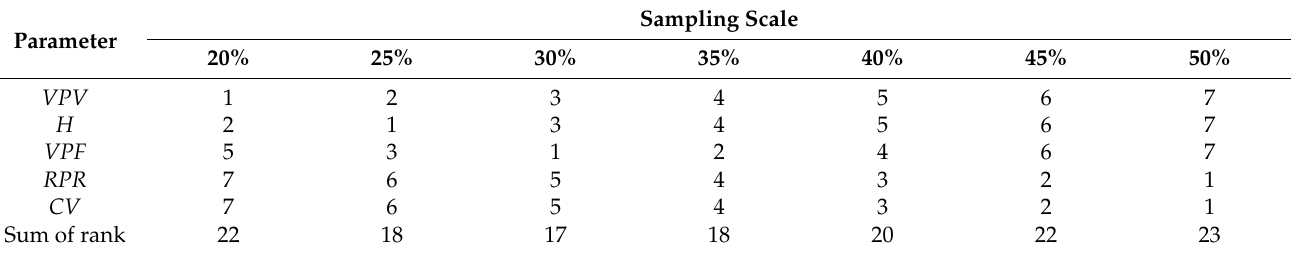
Table 6. Sum of the rank of sampling scales within groups in 203 primary core collections.